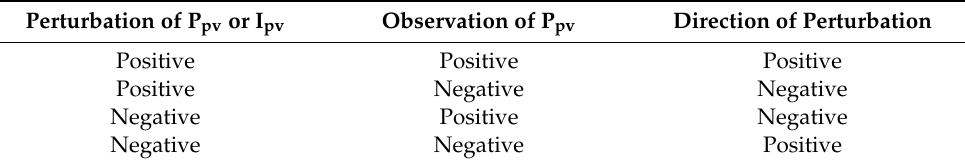
Table 1. Direction of perturbation of P&O